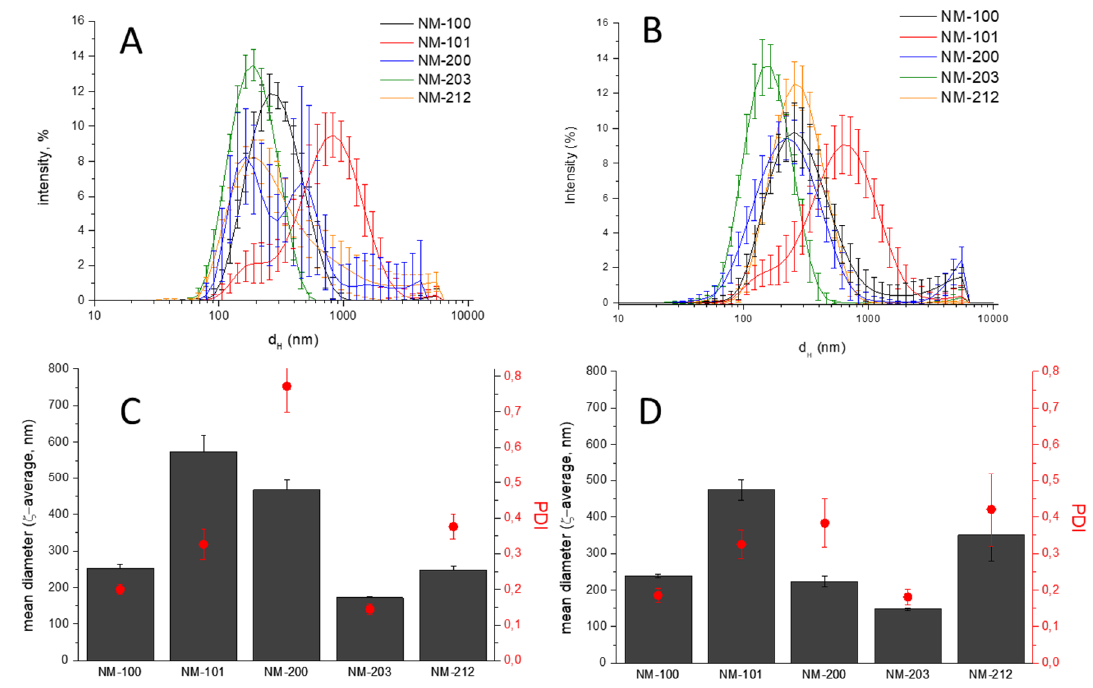
Figure 2. Dynamic Light Scattering (DLS) analysis of stock suspensions. ( A , B ) d H distribution; ( C , D ) mean hydrodynamic diameters (Z D ) and polydispersity index (PDI) values; traditional protocol ( A , C ); and, standardized protocol ( B , D ).